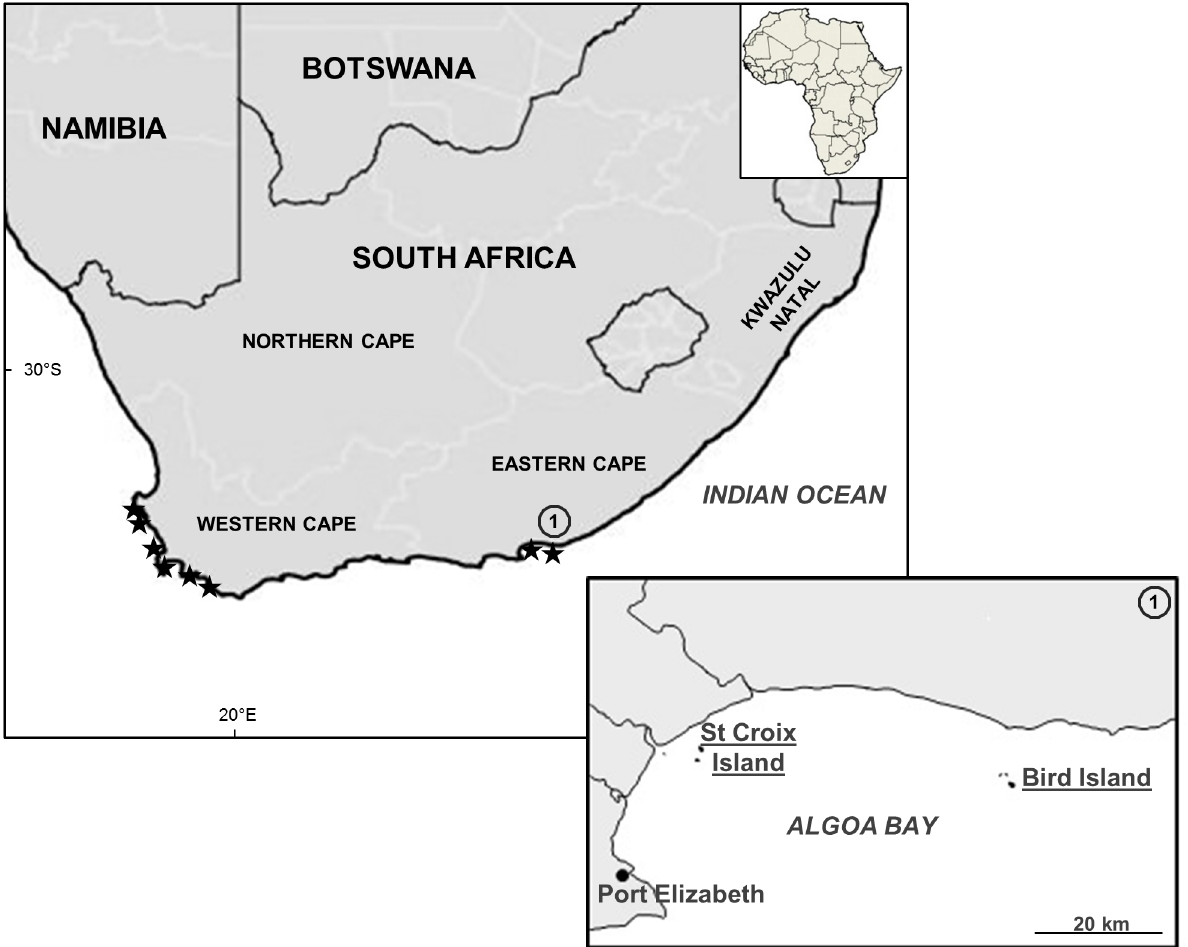
Fig 1. Location of the African penguin colonies along the coast of South Africa ( $ ) and of the two colonies in the Eastern Cape where stable isotope samples were collected.